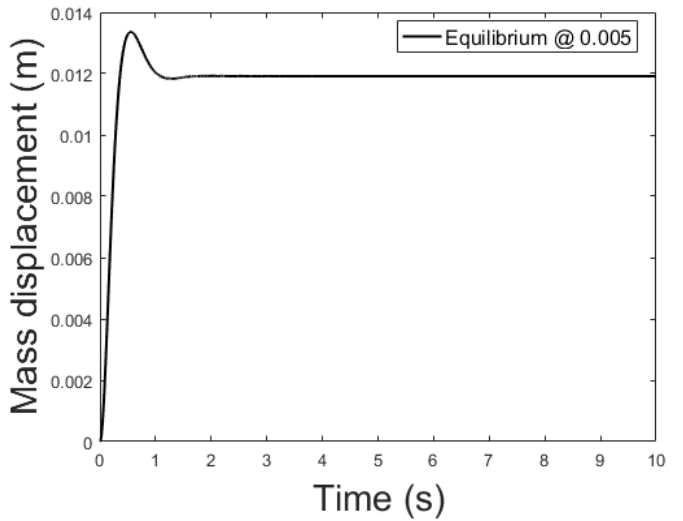
Figure 10. Controlled system output with initial conditions: x 0 = 0 m , equilibrium at x = 0.01.